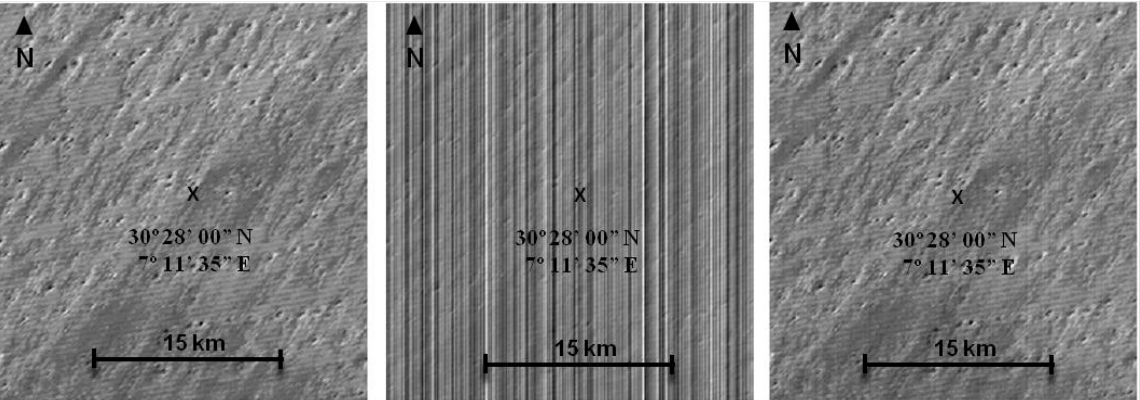
Figure 11. DIRSIG radiance scene of Algeria ( left ). Radiance image calibrated using pre- flight radiometric coefficients ( center ). Radiance image calibrated using pre-flight coefficients with relative correction derived from side-slither data ( right